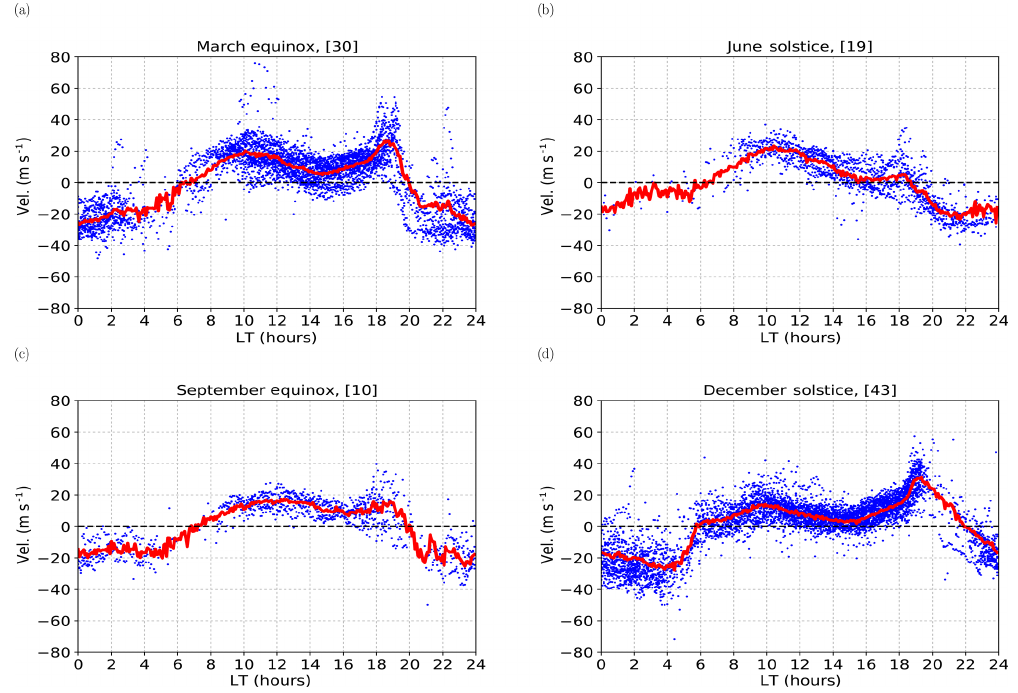
Figure 9. Local time variation of F-region vertical plasma drifts as a function of local time. The red curves represent the averaged vertical drift curves. Each panel represents a season.